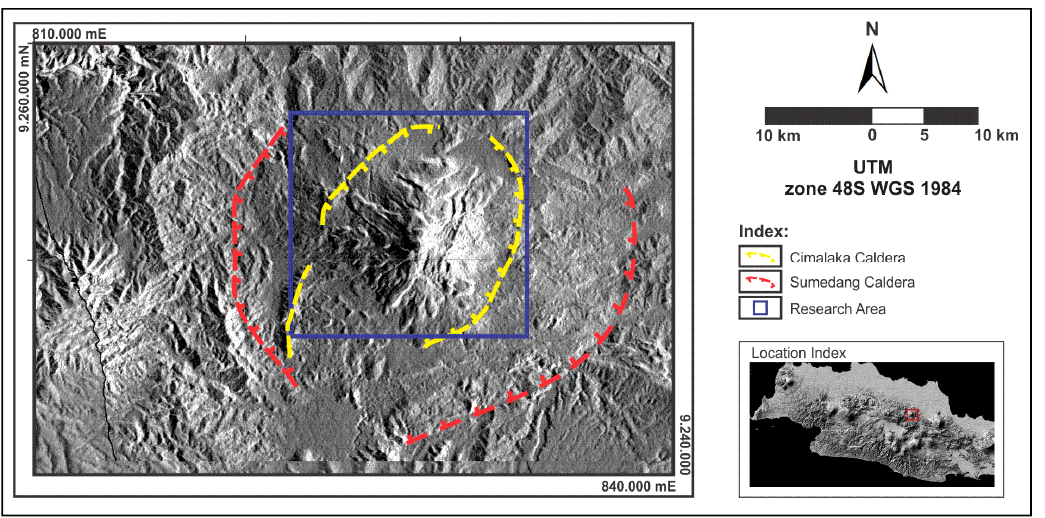
Figure 3. Morphological features of the recent Tampomas Volcano show two parts of the circular caldera rim. The outer caldera rim was formed during the first to second stage, and the inner circular caldera rim is the result of the second and third stage of volcanic activities.